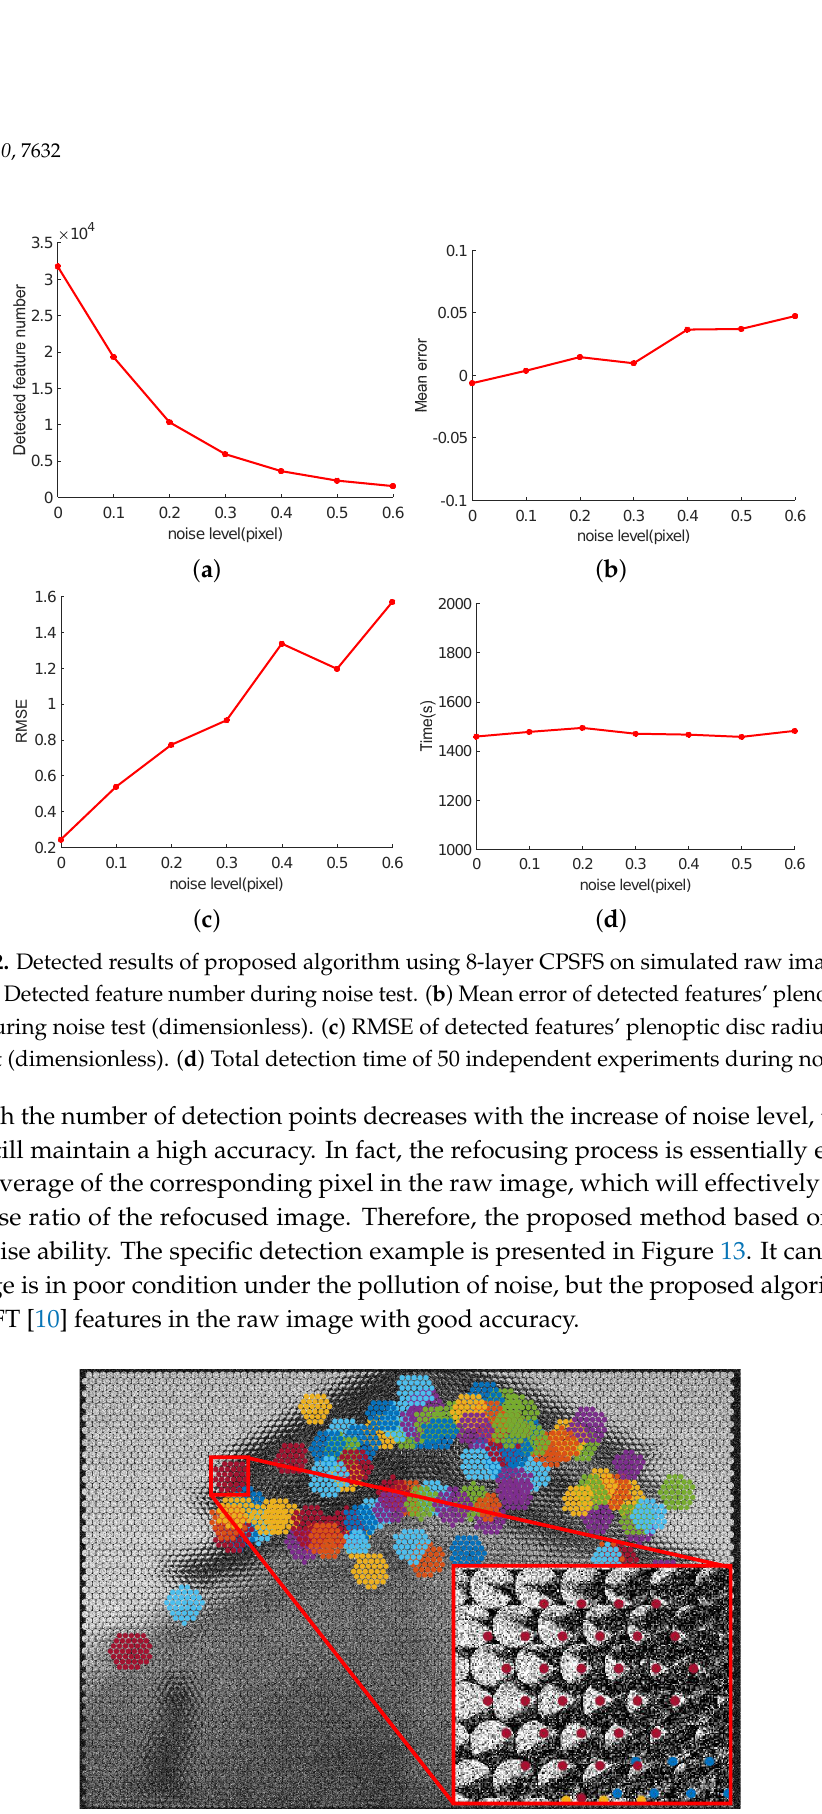
Figure 13. Detection result with noise level σ = 0.3 pixel. The size of simulated raw image is 3000 pixel × 2000 pixel. Note that different colors in figure are used to distinguish the features projected by diverse plenoptic disc